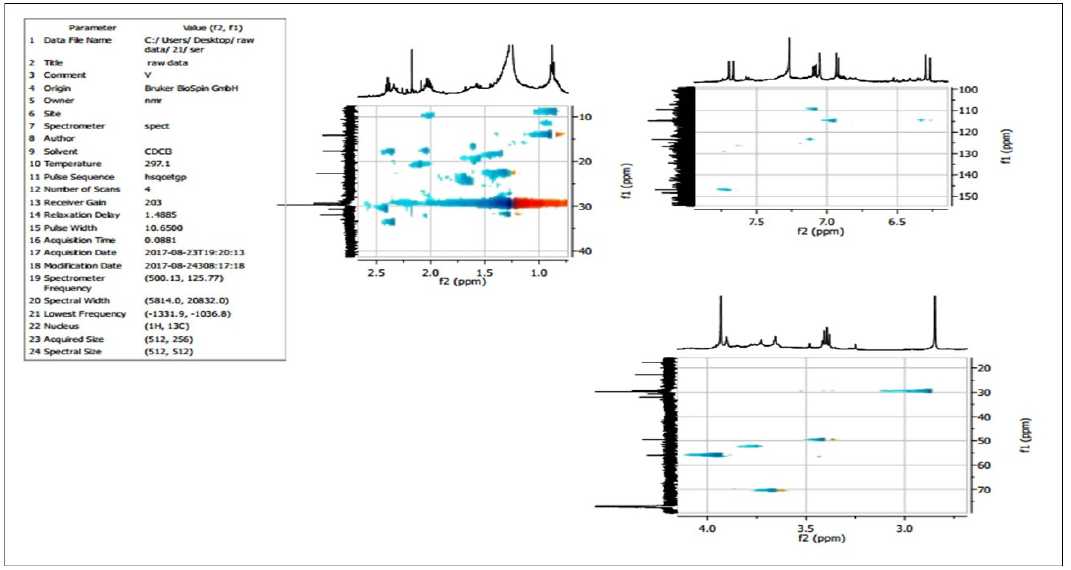
Figure 11. HSQC NMR analysis of the purified compound from the extracts of Leucas indica flowers. Based on the results, one-dimensional and two-dimensional NMR data along with mass spectroscopy revealed that the structure of purified compound was found to be 6- hydroxy-3-(4-hydroxyphenyl)-7-(3,4,5-trihydroxy-6-)(hydroxymethyl)tetrahydro-2H-pyran-2yl)-4H-chromen-4-one (Figure 12).